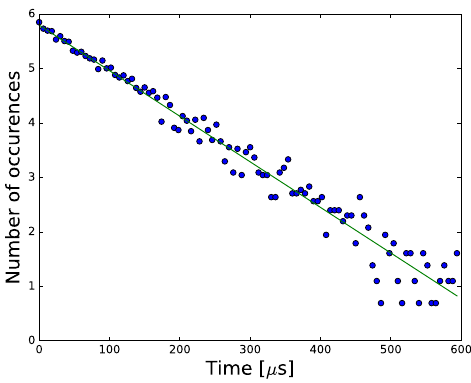
Fig. 3. Histogram of the duration between subsequent arrival times. Dots: experimental data; solid line: time between two emissions for the laser used in our setup.